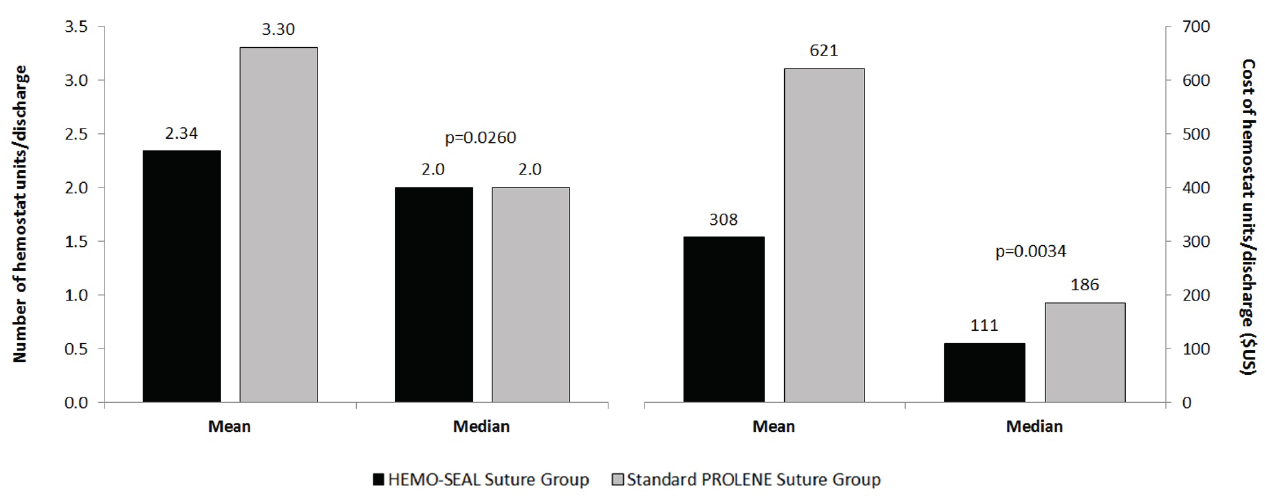
Figure 2. Number and Cost of Hemostat Units per Discharge, by Suture Group